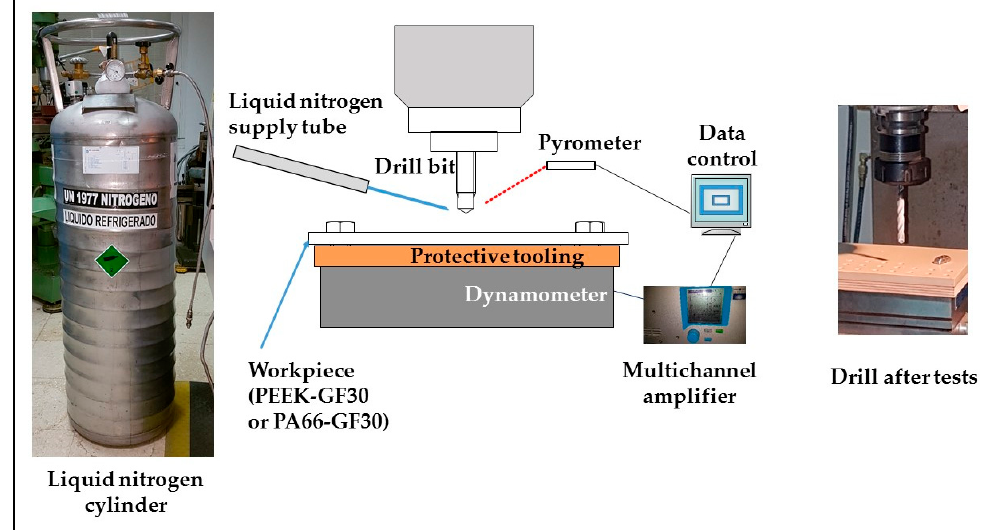
Figure 1. Scheme of experimental setup.